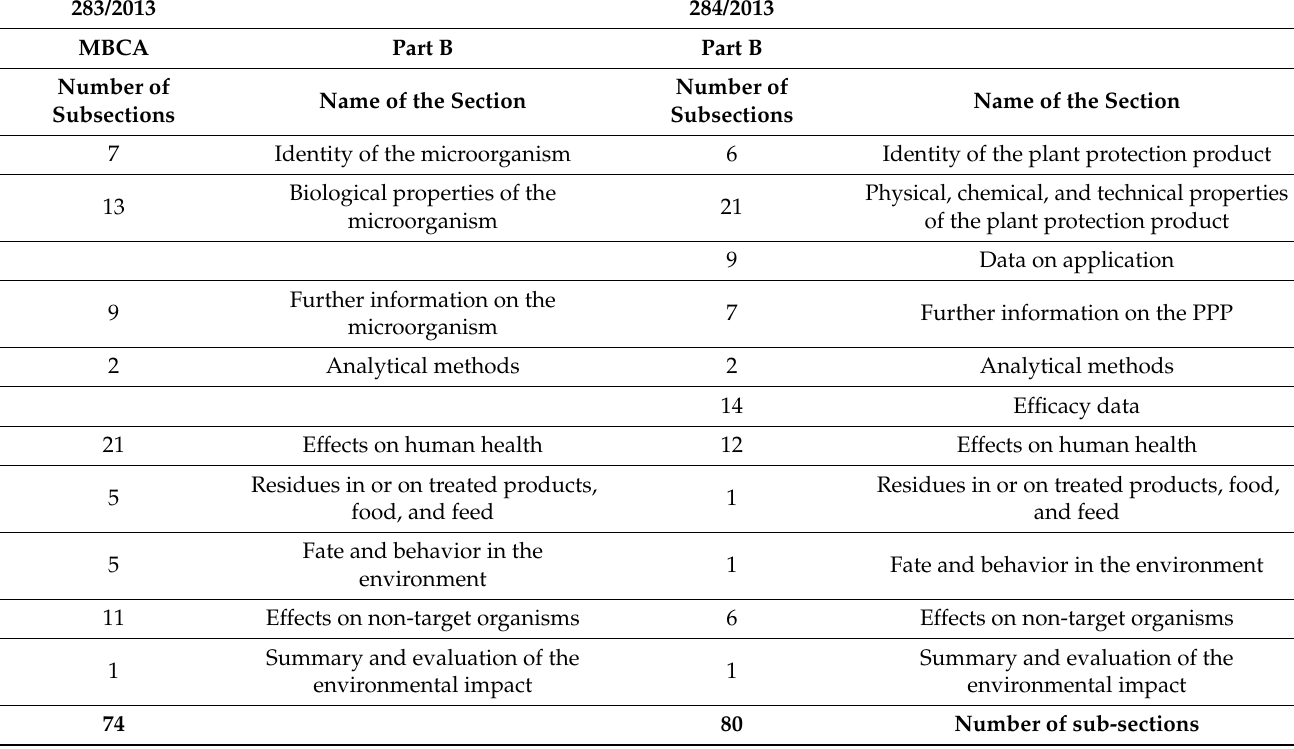
Table 1. Comparison of the sections and number of sections required for completing the dossier for MBCA authorization in Regulation 283/2013 and MBCP approval in Regulation